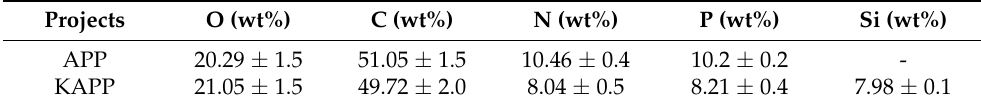
Table 7. Comparison of APP and KAPP surface